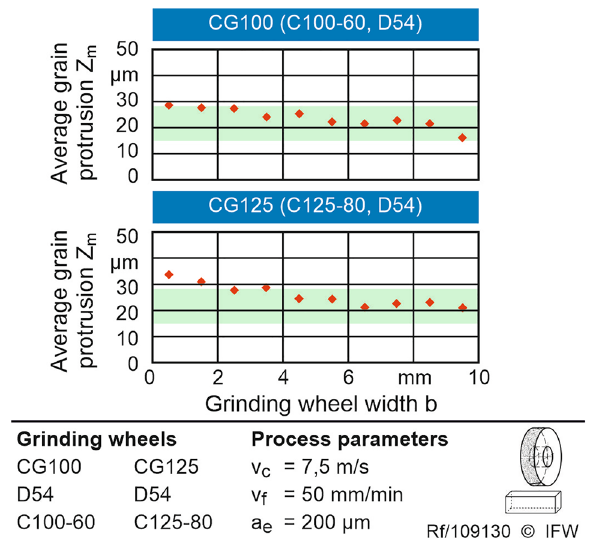
Fig. 9 Course of average grain protrusion for grinding wheels with grain concentration